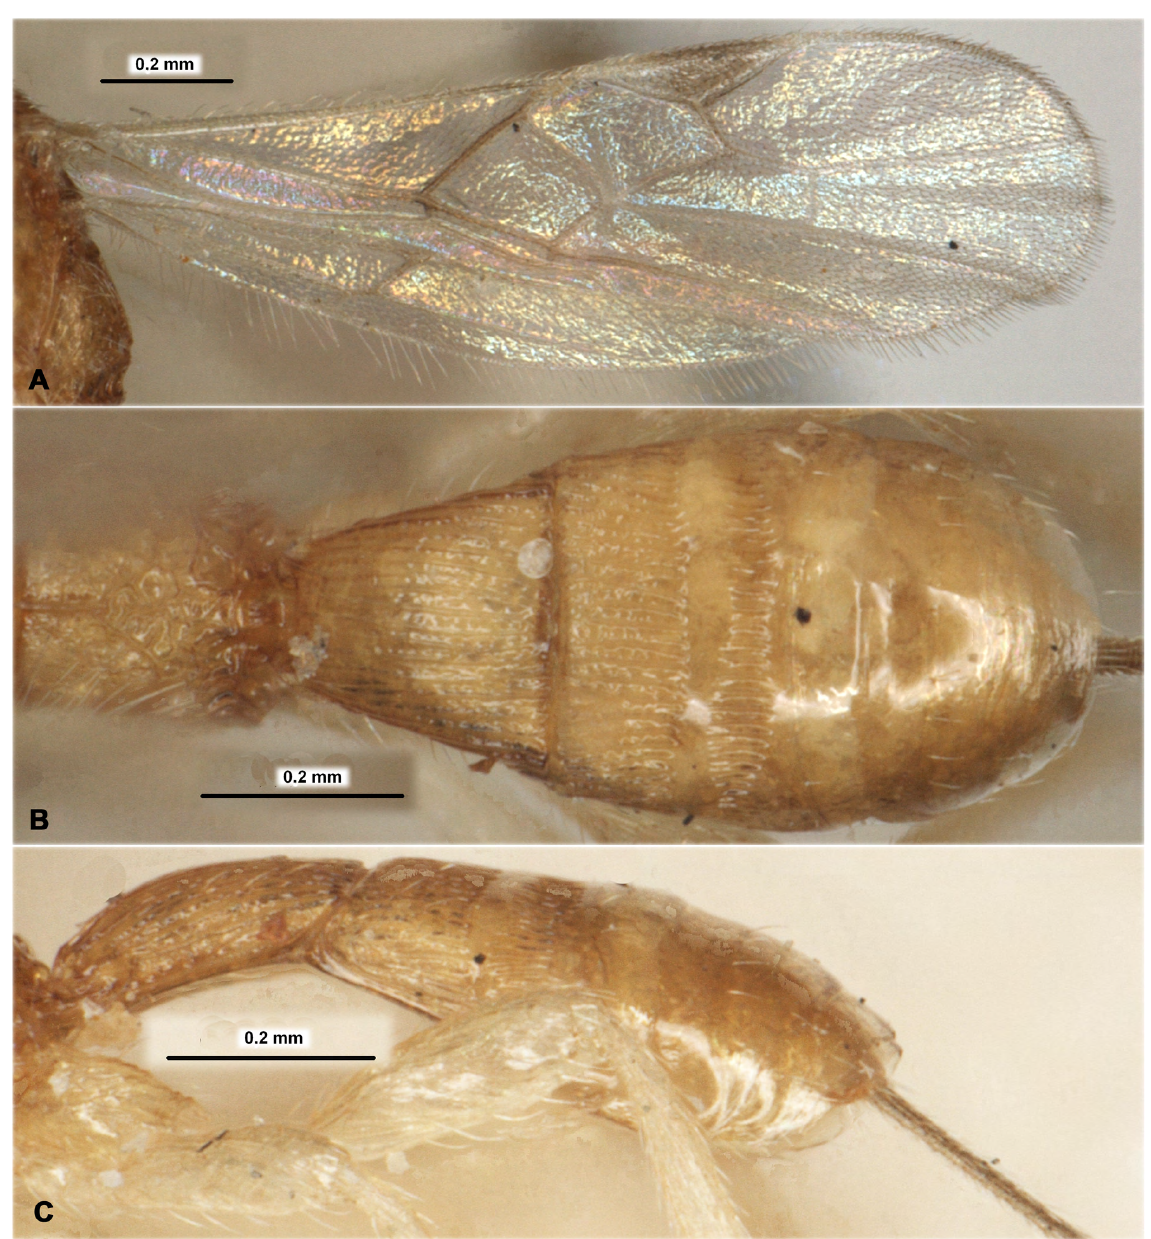
Fig. 55. Rhacontsira saigonensis sp. nov., ♀, holotype, MNHN. A . Wings. B . Propodeum and metasoma, dorsal view. C . Metasoma, lateral